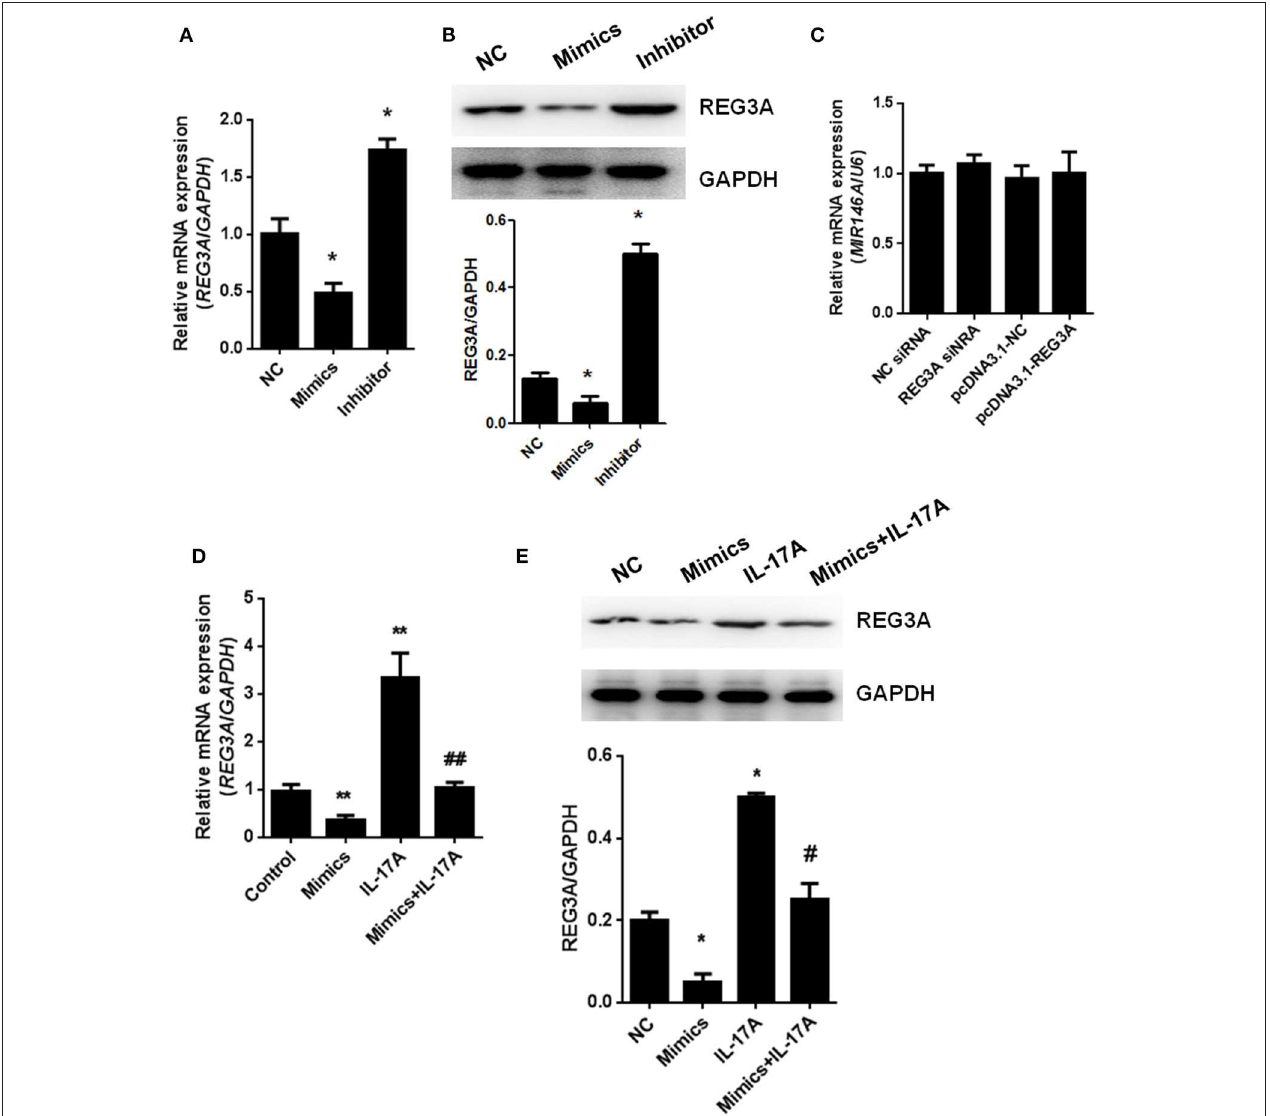
FIGURE 5 | miR-146a regulates regenerating islet-derived protein 3-alpha (REG3A) expression in macrophage. (A,B) Monocyte-derived macrophages from the peripheral blood mononuclear cells (PBMCs) of the healthy donors ( n = 3) were transfected with negative control (NC) microRNA (miRNA), miR-146a mimics, or miR-146a inhibitor for 24h. The messenger RNA (mRNA) and protein levels of REG3A were determined by real-time PCR and Western blot. Glyceraldehyde 3-phosphate dehydrogenase (GAPDH) was used as the internal controls. (C) The cells were transfected with NC small-interfering RNA (siRNA), REG3A siRNA, pcDNA3.1-NC, and pcDNA3.1-REG3A plasmids for 24h. The mRNA levels of miR-146a were determined by real-time PCR. U6 was used as the internal controls. (D,E) The cells were transfected with NC miRNA or miR-146a mimics in the absence or presence of IL-17A for 24h. The mRNA and protein levels of REG3A were determined by real-time PCR and Western blot. GAPDH was used as the internal controls. Data are shown as means ± SEM of three independent experiments. * p < 0.05, ** p < 0.01 in comparison with the control group. # p < 0.05, ## p < 0.01 in comparison with IL-17A treatment